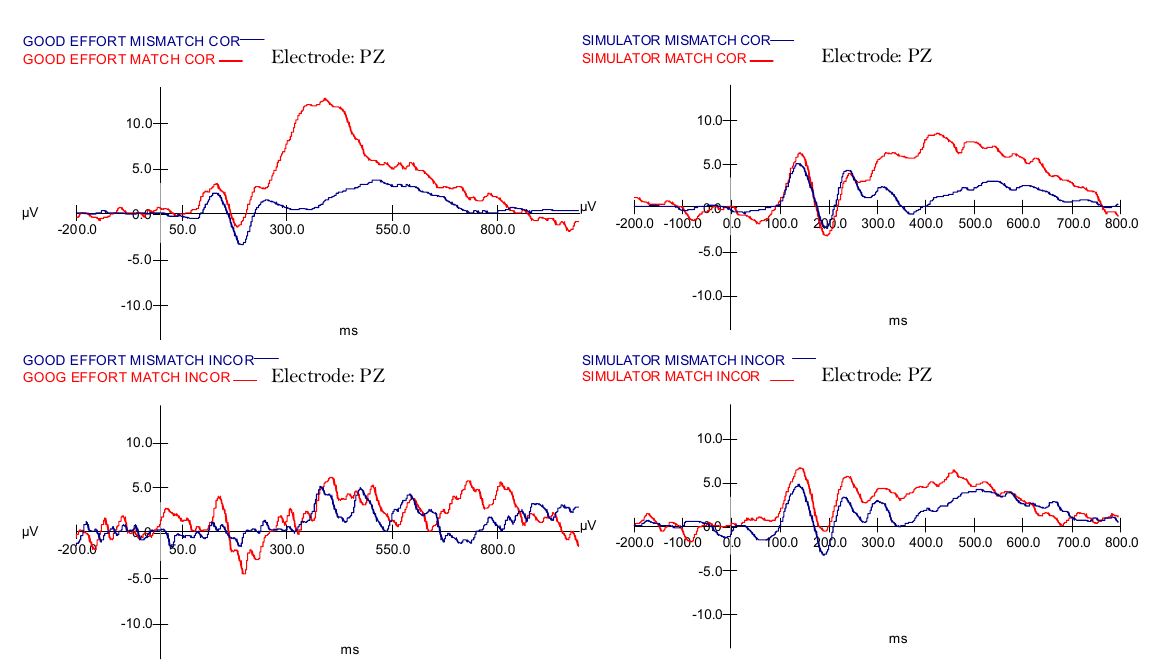
Figure 4. Grand average waveforms for P3 for Malingering and Full Effort groups, showing the effects of behavioral response accuracy.